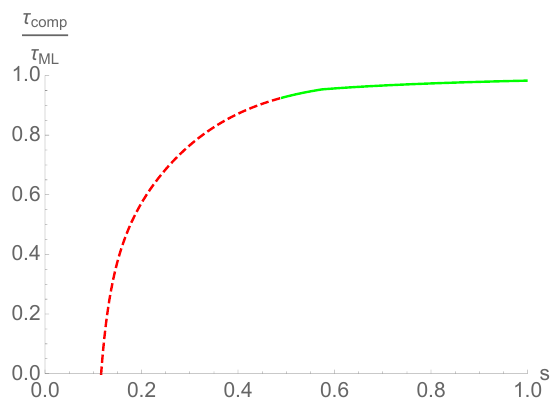
Figure 5 . A violation of Lloyd’s bound at x = : 8. The assumptions of Lloyd’s bound are satis(cid:12)ed at the transition region between stable (blue) and unstable (red)